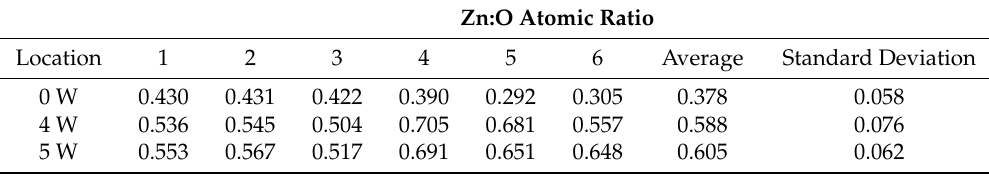
Table A1. EDS Investigation of Zn:O atomic ration at random positions on printed pattern.